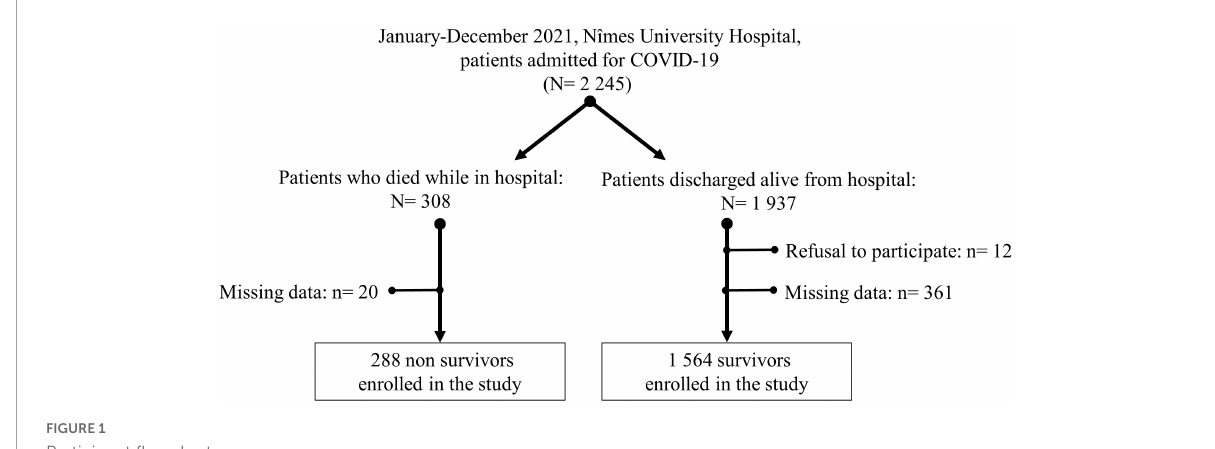
FIGURE1 Participant